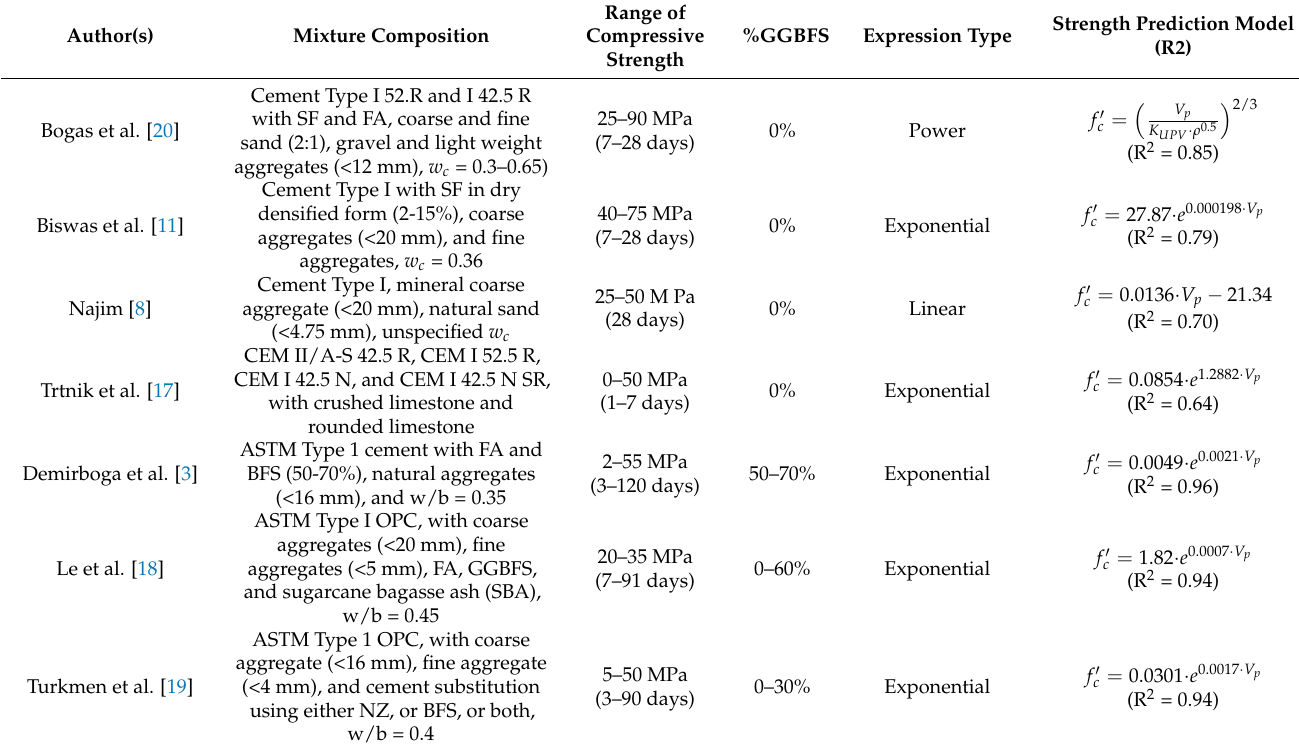
Table 1. Established empirical equations for f (cid:48) c and V p